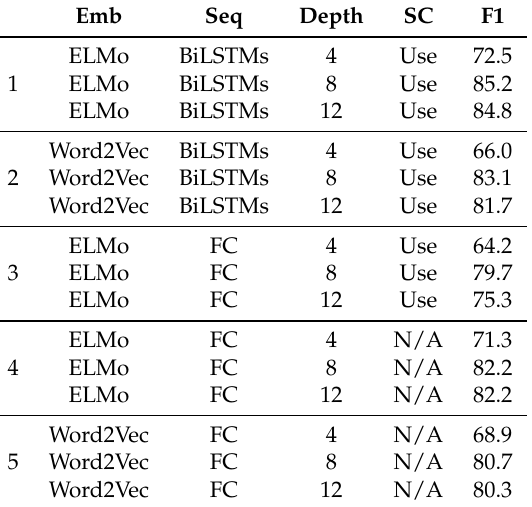
Table 3. Ablation study results.